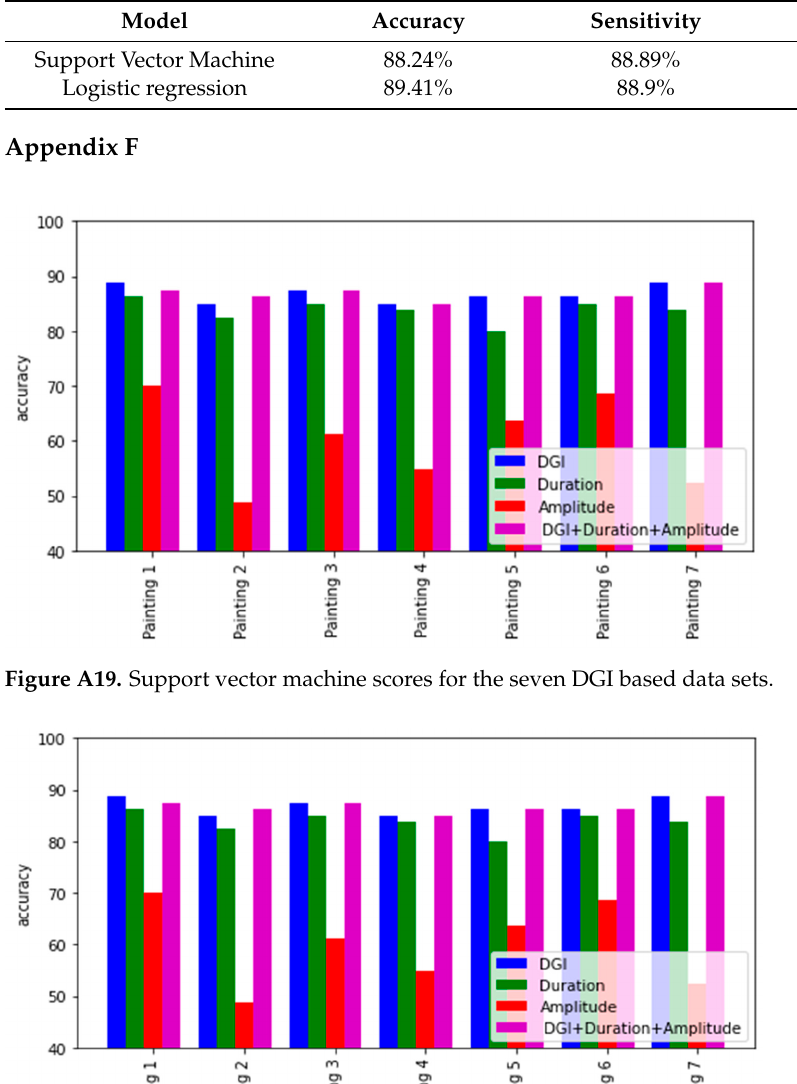
Table A5. SVM and logistic regression scores when trained on the seven paintings dataset using AIDEAL eye movement features.